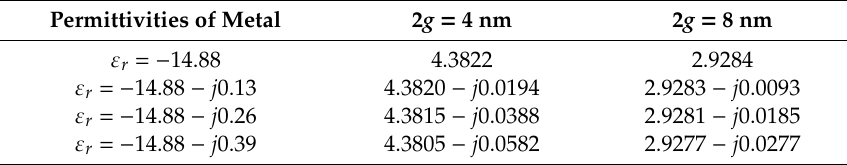
Table 2. Guide wavelengths ( λ g ) with respect to the Ag permittivity and modified permittivities, when the gap width 2 g of 4 and 8 nm are used. ( ε r = − 14.88 − j 0.39 at λ 0 = 582.08 nm